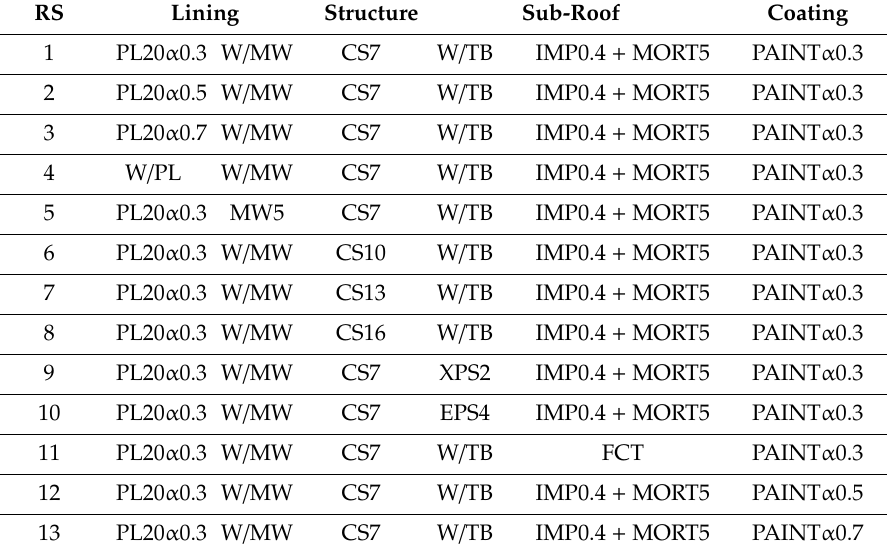
Table 12. Roofing systems (RS) for numerical